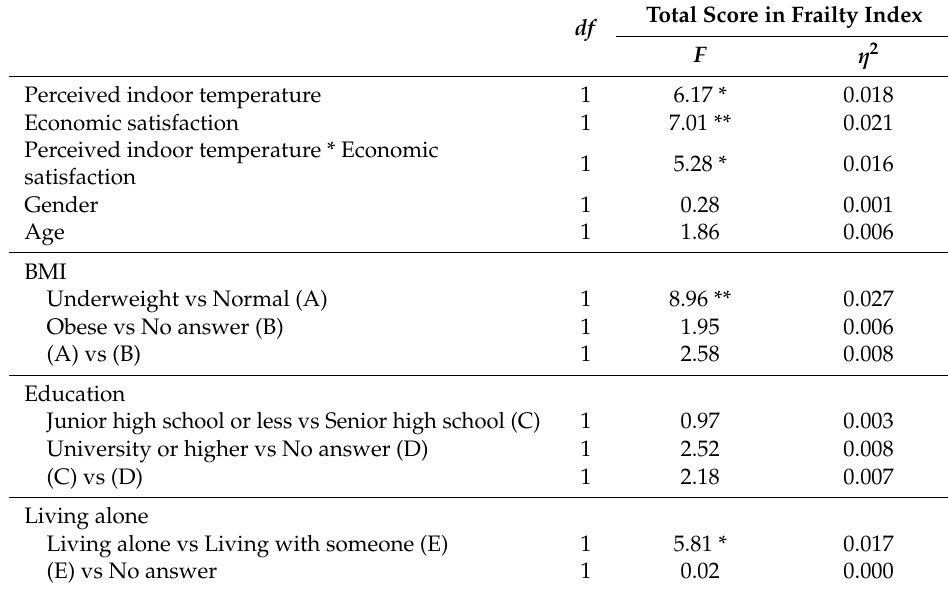
Table 3. ANCOVA of total frailty score by perceived indoor temperature and participant characteristics ( n = 342).